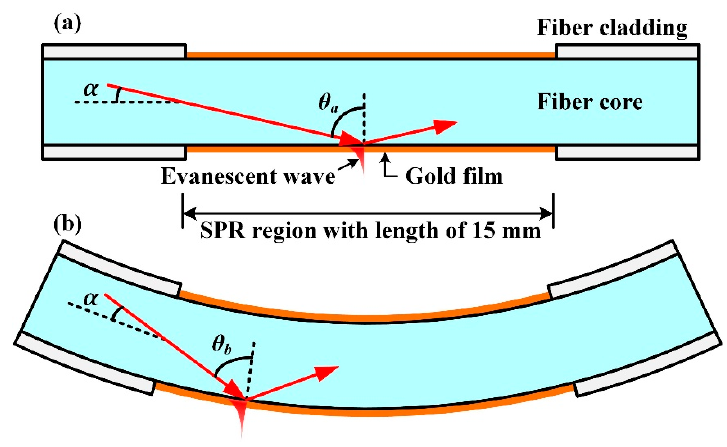
Figure 1. The sketch diagram of the fiber SPR (Surface Plasmon Resonance) bending sensor. ( a ) SPR region in the straight case; ( b ) SPR region in the bending case.